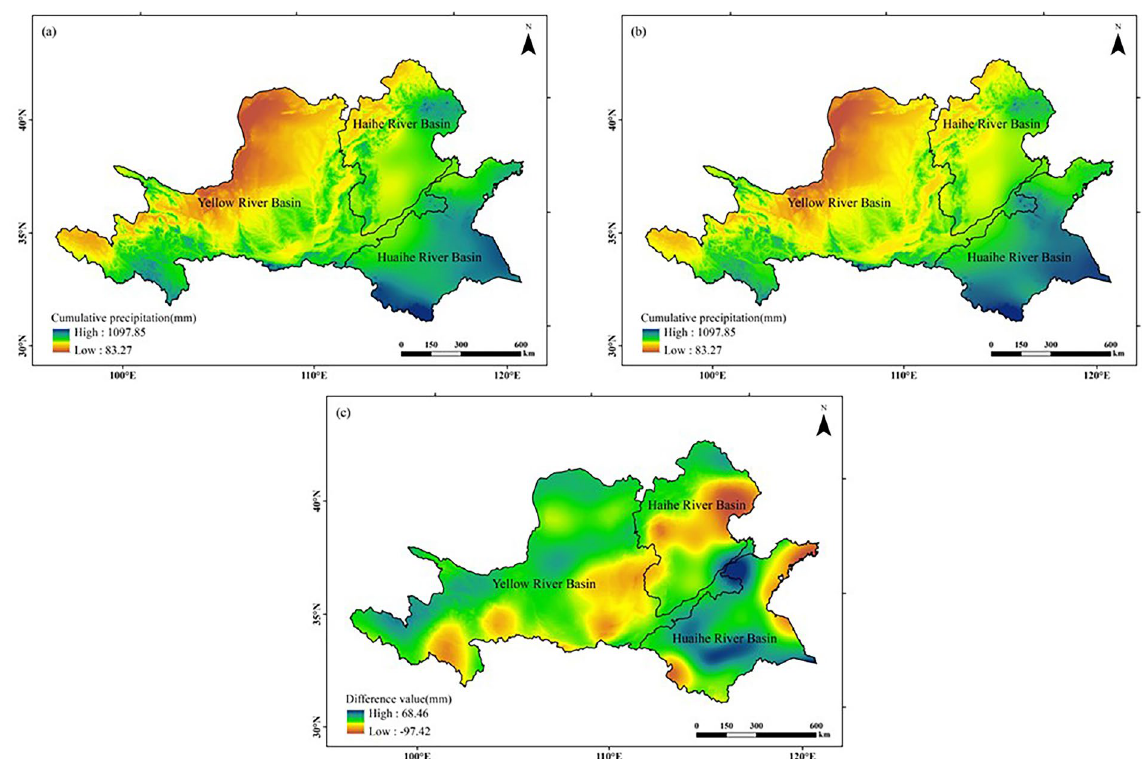
Figure 3. Comparison of cumulative precipitation distribution during peanut growing seasons in the Huang- Huai-Hai region in two climatic years: ( a ) 1960–1989, ( b ) 1990–2019, ( c ) ( b )–( a ). The figure was made in the ArcGIS 10.2 platform (https:// www. esri. com/ en- us/